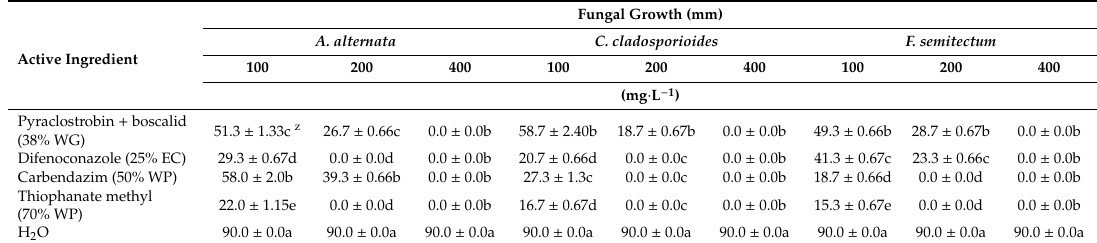
Table 4. E ff ect of four fungicides at 100, 200, and 400 mg · L − 1 against isolated pathogenic fungi growth (mm) in vitro recovered from ‘Anna’ apples after premature fruit drop.